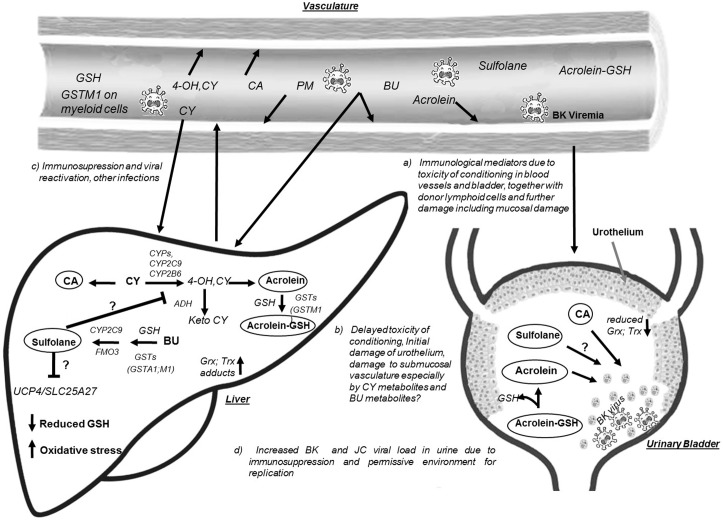
Hypothetical model for Hemorrhagic Cystitis occurrence in children receiving BU-CY regimen prior to allogeneic HSCT. Busulfan (BU) and cyclophosphamide (CY) metabolism predominantly occurs in the liver generating the water soluble metabolites sulfolane (Su) and acrolein (Ac), respectively. During the metabolic process BU utilizes glutathione (GSH) and activity of GSTs such as GST alpha 1 (GSTA1), GST mu1 (GSTM1) plays an important role in conjugation of BU with GSH. GSH is also essential for scavenging the CY active metabolites including Ac also catalyzed by GSTs. When CY is administered after BU, the water soluble metabolite of BU, i.e., Su could influence the activity of cytochrome P 450 enzymes (CYPs) and thus might affect the activation of CY, or on the other hand higher Su levels also represents the utilization of GSH and formation of γ-glutamyl-dehydroalanyl-glycine (EdAG) affecting the availability of reduced form of GSH. Su might also affect the function of GSTs and other enzymes in BU, CY metabolism and proteins such as Mitochondrial uncoupling proteins (UCP) encoded by SLC25A27 gene affecting cell survival. Su possibly affect the function of ADH (alcohol dehydrogenase) enzyme resulting in increased levels of hydroxy CY metabolite, resulting increased Ac formation. BU could irreversibly alkylate the glutaredoxins (Grx) and Thioredoxins (Trx) increasing the oxidative stress, thus increasing toxicity of incoming CY metabolites such as 4 hydroxy cyclophosphamide (4OH-CY); Ac, chloro acetaldehyde (CA), and Phosphoramide mustard (PM). Altered activity of CYPs due to less functional alleles in the encoding genes might have a predictable function of Su formation and CY activation. Circulating CY metabolites (4OH CY, PM) including Ac inhibit cytokine function by alkylation and also cause immunosuppression, further increasing the chances of viremia and viruria (BK and/or JC virus). Ac conjugated with GSH in the liver gets delivered to the bladder and releases free Ac which then could alkylates cysteine residues and causing toxicity. Altogether increased rate of metabolite delivery to the urinary bladder together with viral load and lack of protection due to increased oxidative stress, endothelial damage to the blood vessels, urothelial damage and enhanced viral replication results in bladder inflammation and hematuria and the condition hemorrhagic cystitis.